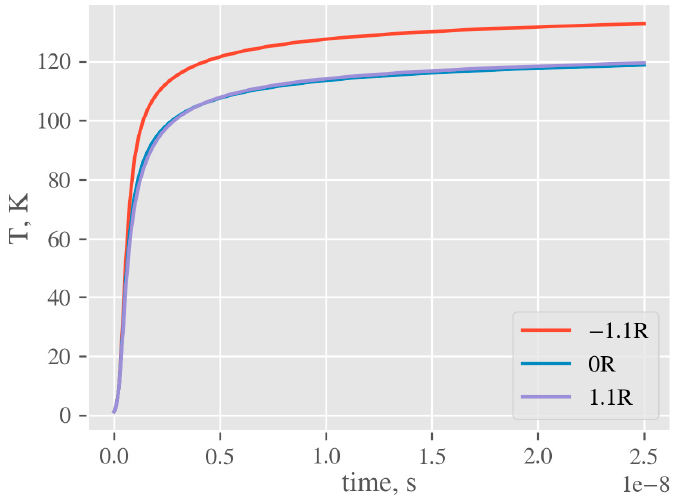
Figure 14. Temperature evolution of AgNP core for different immersion depths (PET, G = 50 MW m − 2 K − 1 ).